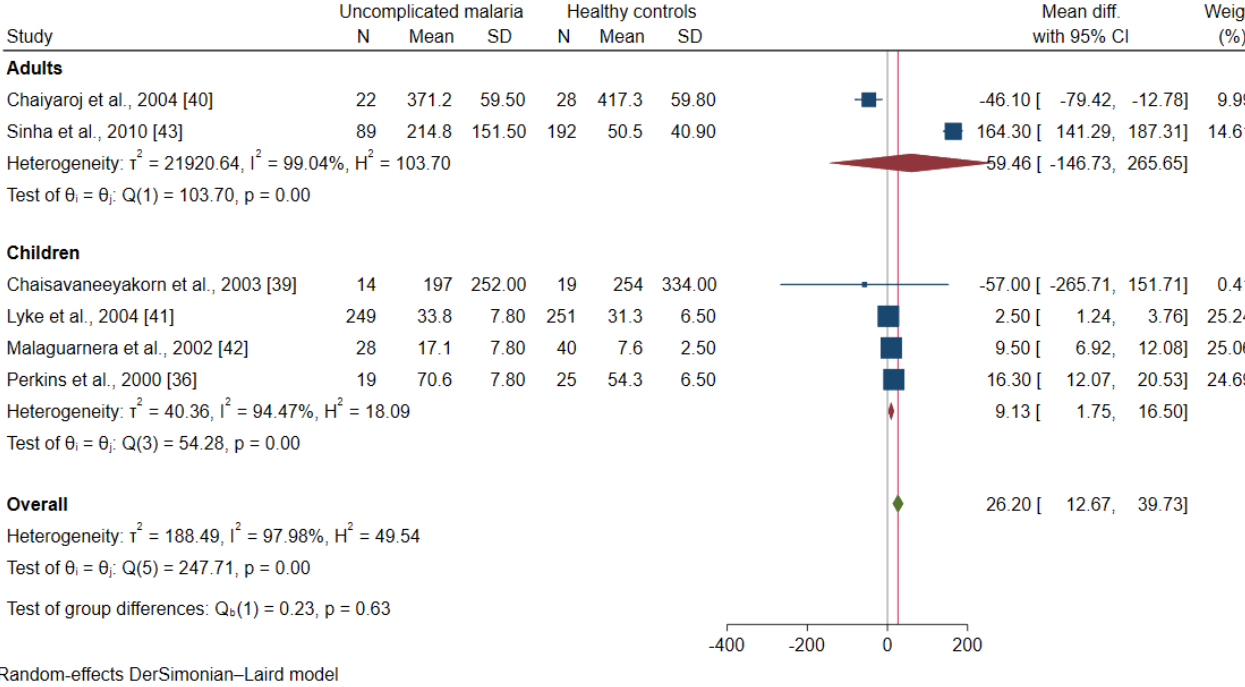
Figure 7. Forrest plot demonstrated the difference in the mean IL-12 levels (pg/mL) between patients with uncomplicated malaria and healthy controls by age groups [36,39–43]. Abbreviation: Mean Diff., mean difference; CI, confidence interval. Explanation of the forest plot: squared-box symbol, point estimate; green diamond and red line: pooled mean difference: red diamond: pooled mean difference in each subgroup; blue line: line of no effect; I 2 , level of heterogeneity; p = 0.00 or less than 0.05, significant